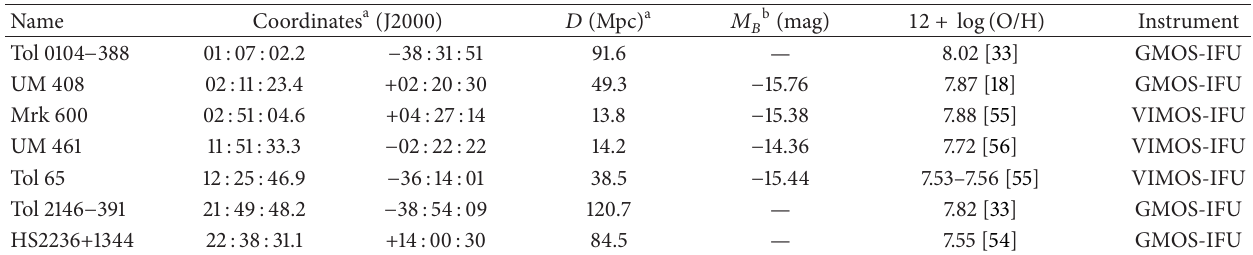
Table 2: General parameters of our studied galaxies.